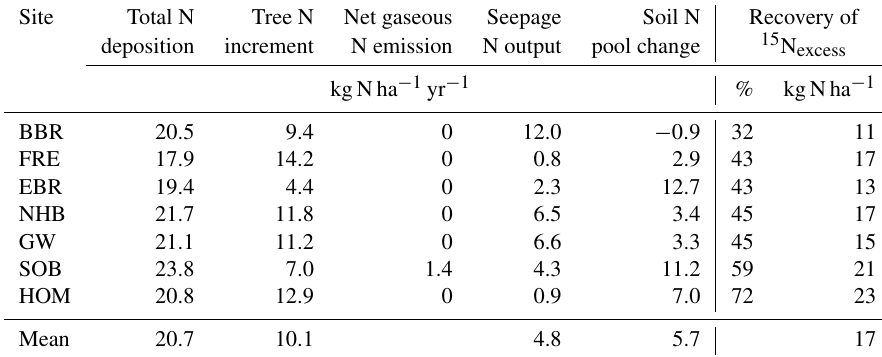
Table 5. Average total N deposition ( N D ), tree N increment ( N U ), net gaseous N emission ( N E − N F ), seepage N outputs ( N L ), and soil N pool change ( (cid:49) N S , calculated from Eq. 1) for the period 1994 to 2008 and 15 N recovery of applied labeled 15 N with leaf litter of seven European beech ( Fagus sylvatica L.) forest ecosystems. The 15 N recovery 5.5 years after litter exchange is given in percent of applied − 1 of N of mean annual leaf litterfall 15 N excess and in kgha